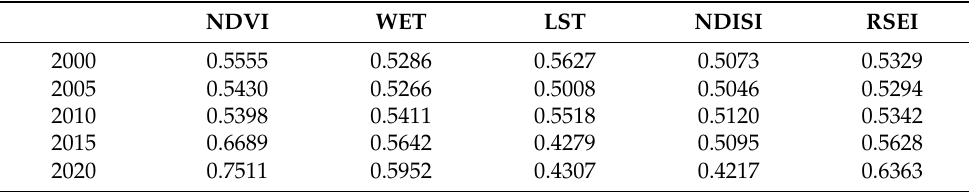
Table 4. Mean indicators of RSEI from 2000 to